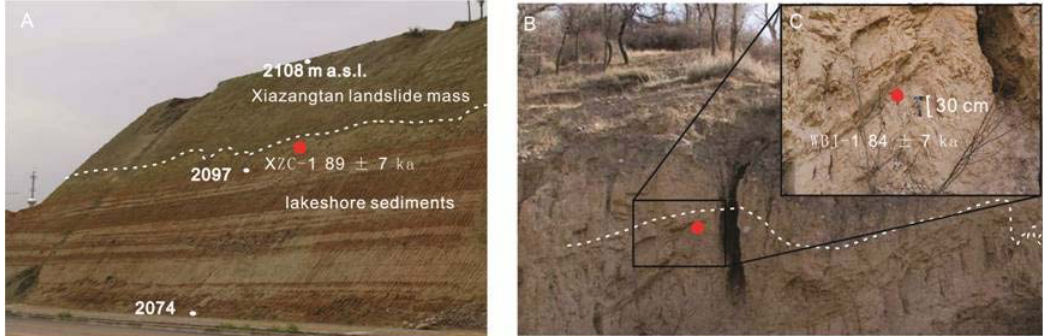
Figure 4. Google images for Xiazangtan, Kangyang and Lannitan landslides, which are abbreviated as XZT, KY and